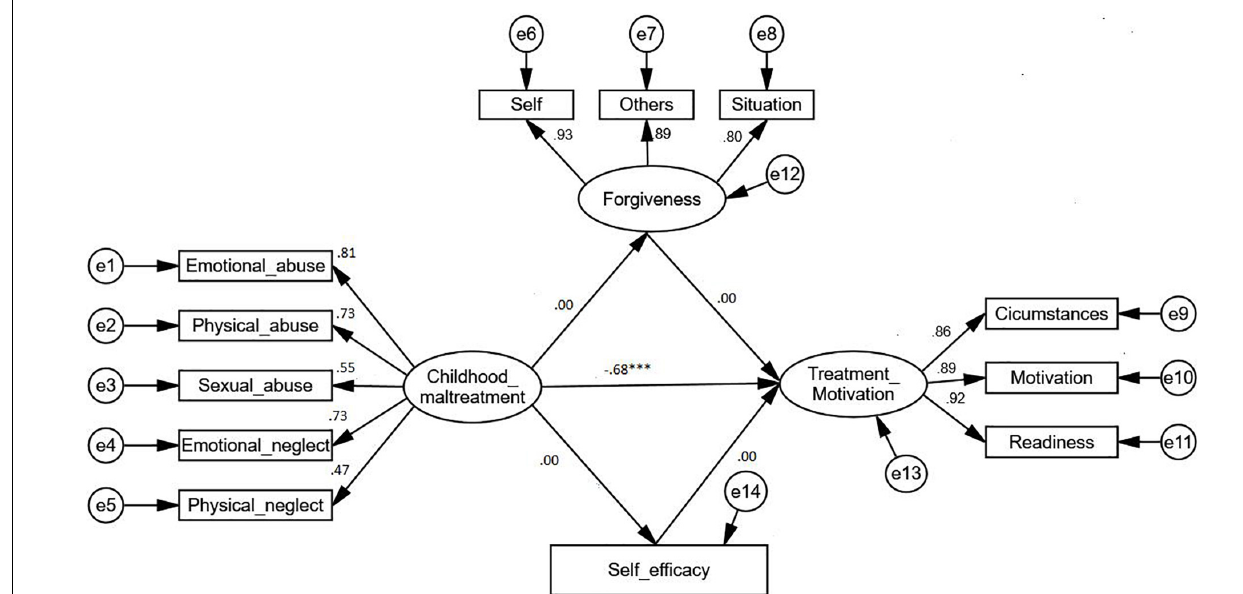
FIGURE 3 | The direct model. ∗∗∗ p ≤ 0.001.